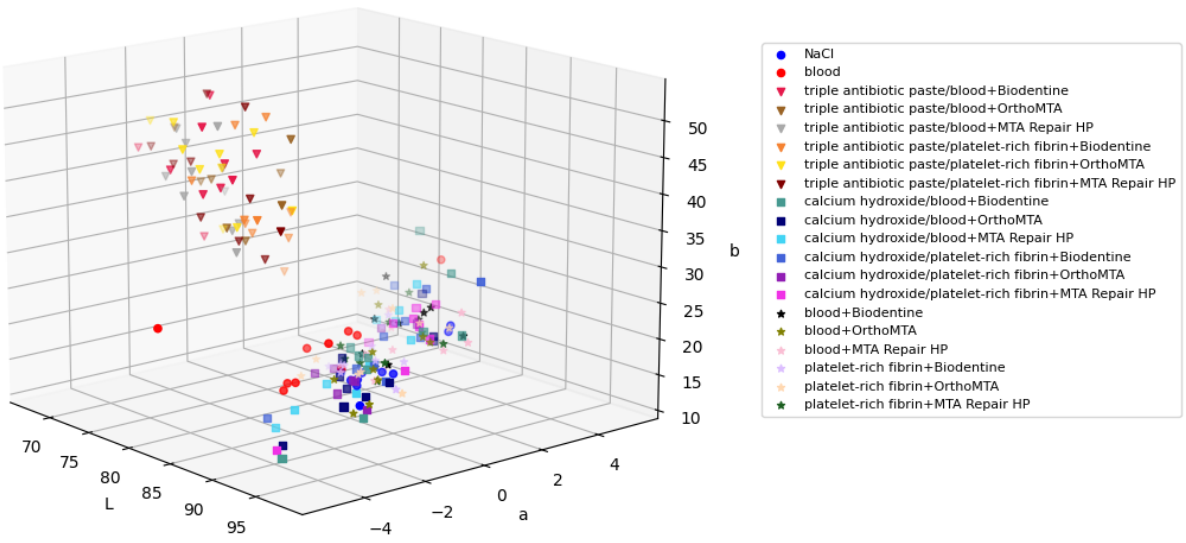
Figure 10. Three-dimensional scatter plot in the CIELab colour space (L, a, and b coordinates) of mean colour distribution of the groups after applying the disinfectant paste.